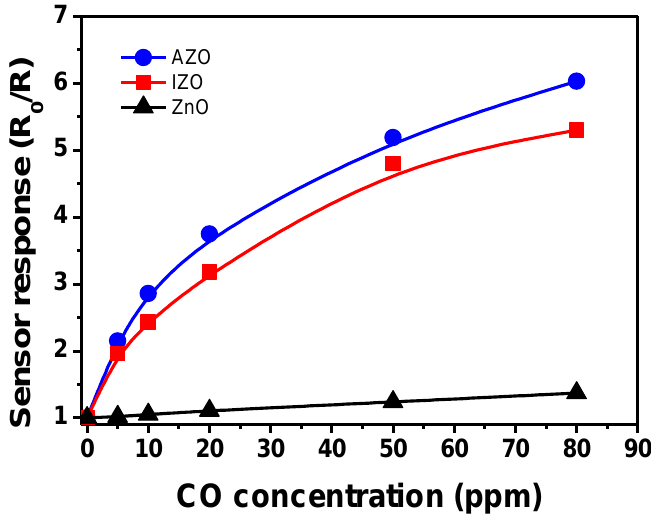
Figure 5. CO response of pure and doped ZnO nanoparticles as a function of CO